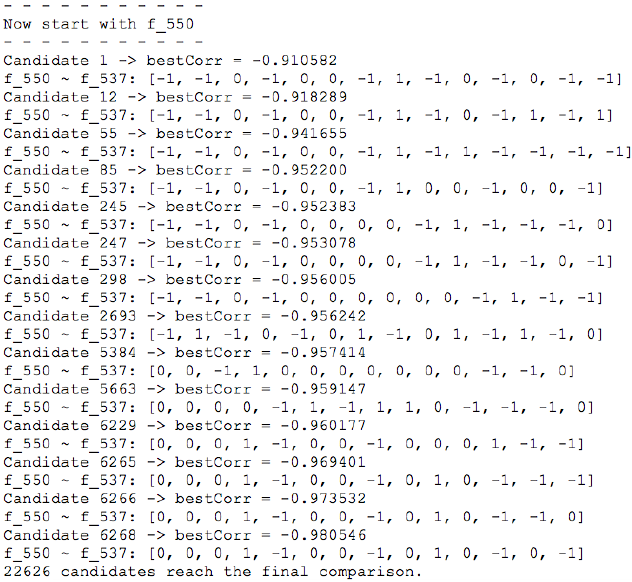
Figure 13: The HIDCPA on the Optimized NTRU Prime